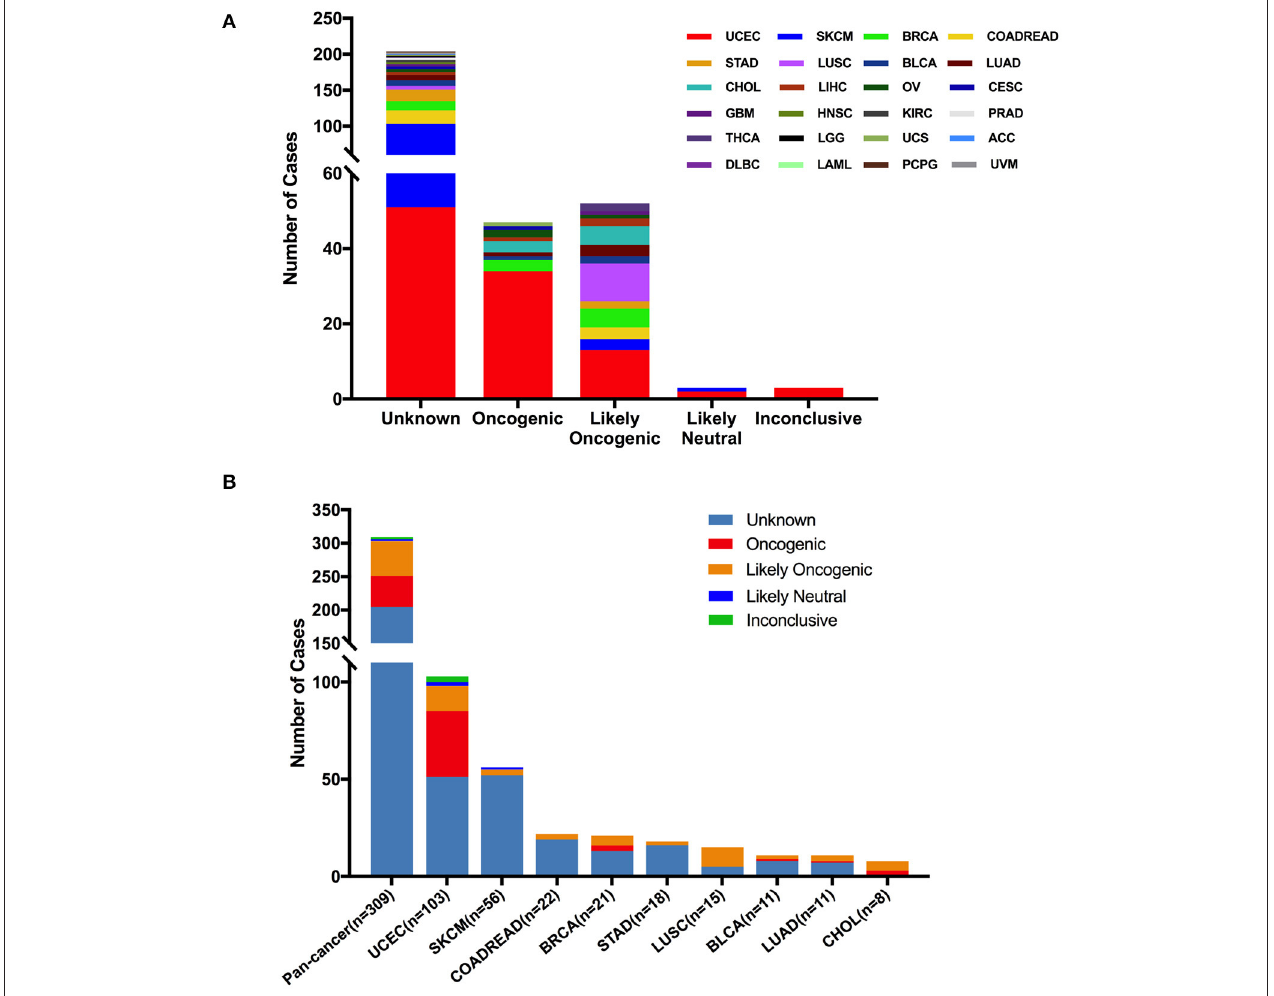
FIGURE 5 | FGFR2 mutation distribution based on functional impacts. (A) FGFR2 mutation classification by functional impacts on all cancer types together. (B) Functional impact class distribution of FGFR2 mutations in all and top 9 cancer types.